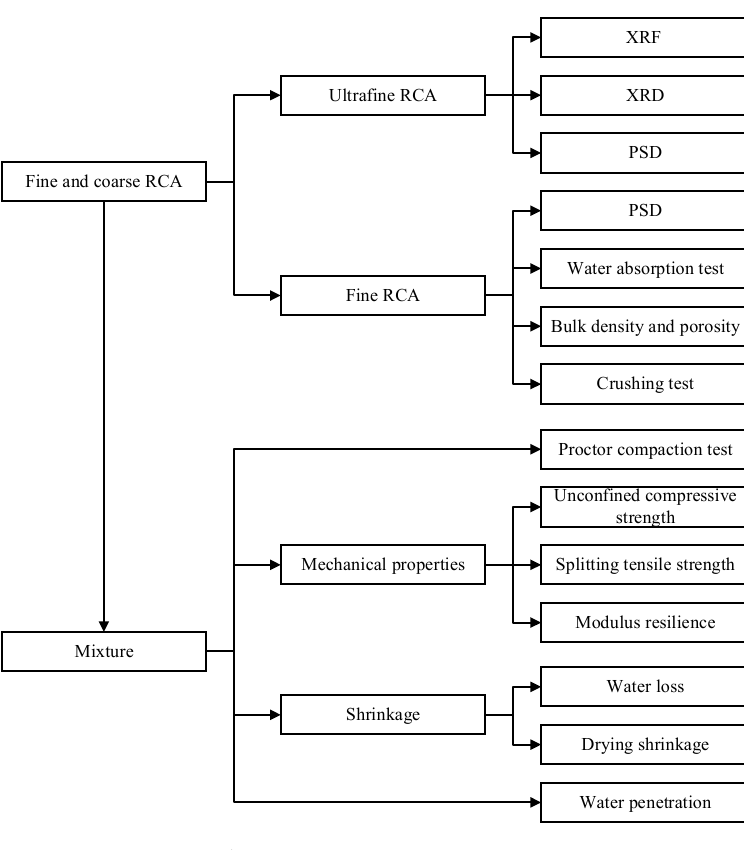
Figure 2. Testing